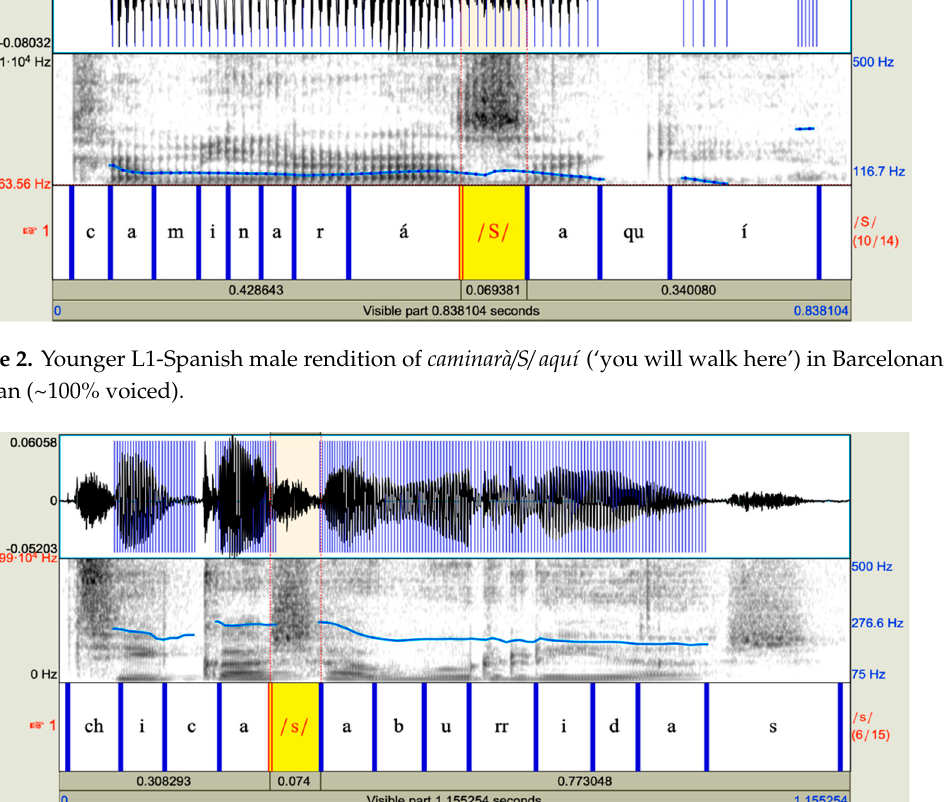
Figure 3. Younger L1-Spanish female rendition of chicas aburridas (‘bored girls’) in Valencian Spanish (~6% voiced).